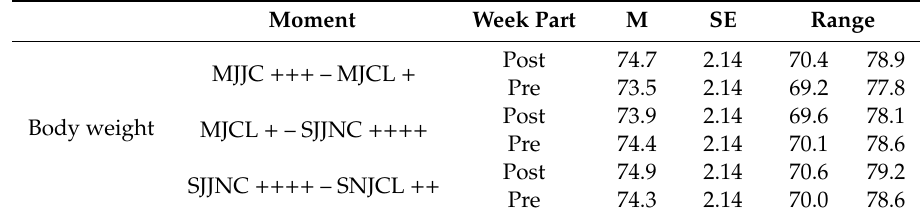
Table 4. Changes (mean M, standard error SE and range) among the di ff erent moments and comparing the pre and post competitions for the body weight variable (kg).